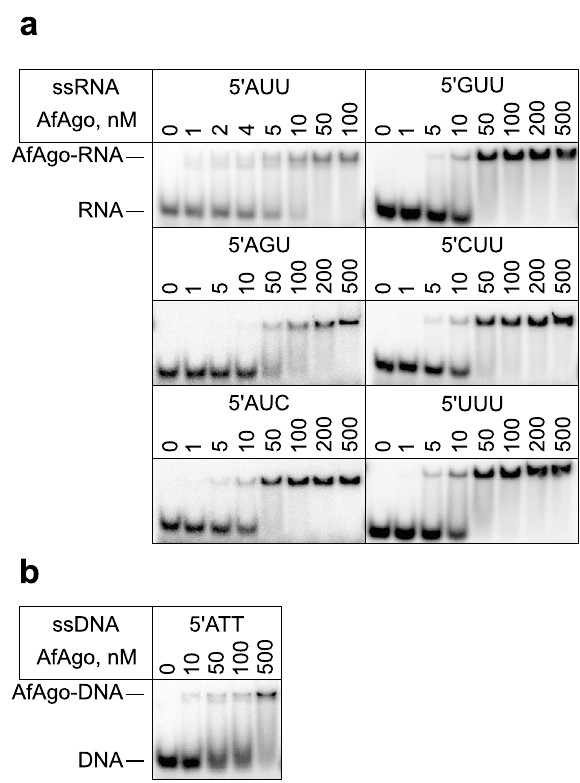
Figure 2. AfAgo interactions with nucleic acids in vitro. EMSA experiments were performed with 5 nM total 5 ′ P-ssRNA ( a ) and ssDNA ( b ), and varying concentrations of AfAgo, indicated above each lane. Calculated K d values are provided in Table 1.